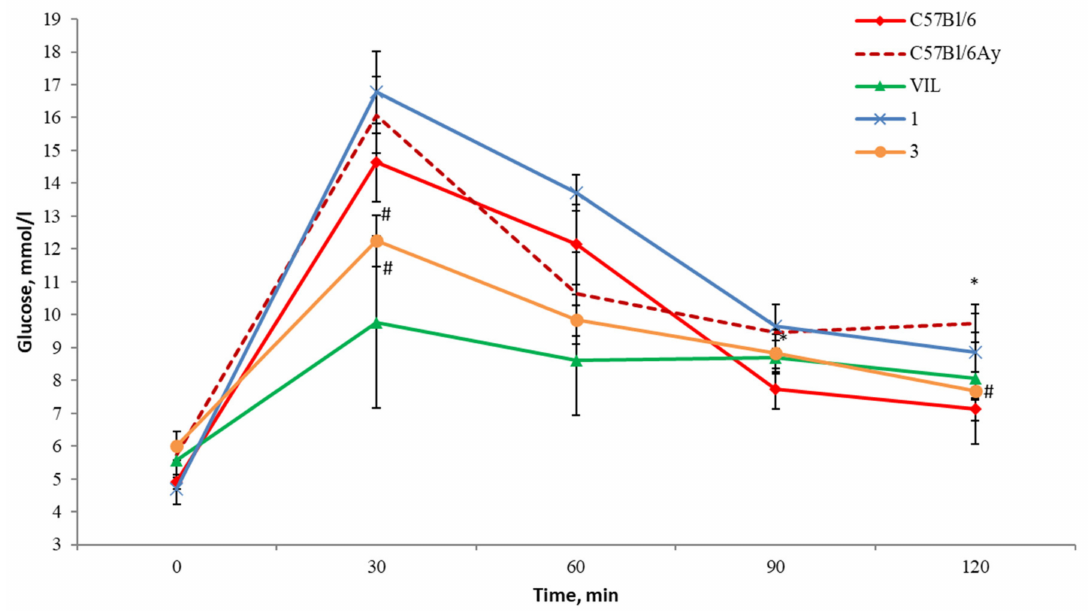
Figure 4. OGTT results in AY mice after 14 days of drug administration at a dose of 30 mg / kg. * p < 0.05 as compared with untreated C57BL / 6 mice, # p < 0.05 as compared with untreated AY